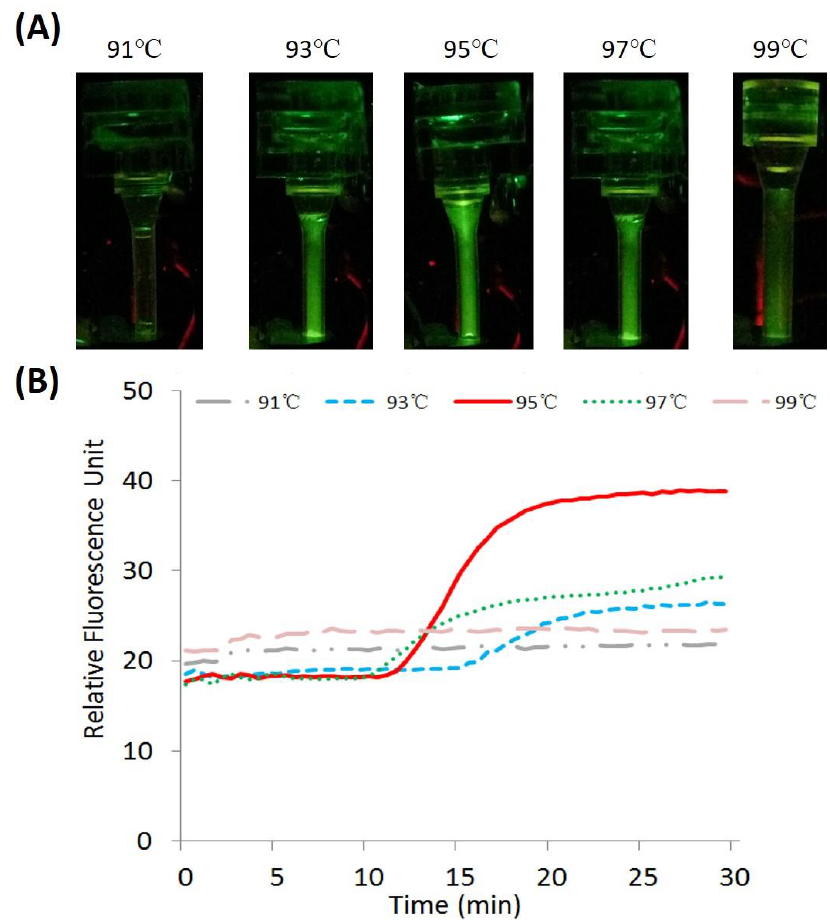
Figure 7. CPCR with H1N1 virus templates. In details: ( A ) end-point fluorescent images of amplicons with different heating temperatures; ( B ) analyzed real-time fluorescence curves with different heating temperatures, the long-dashed line, dotted line, solid line, short-dashed line, and dashed and dotted line, respectively, correspond to experiments with different setpoint temperatures, 99 °C, 97 °C, 95 °C, 93 °C, and 91 °C.